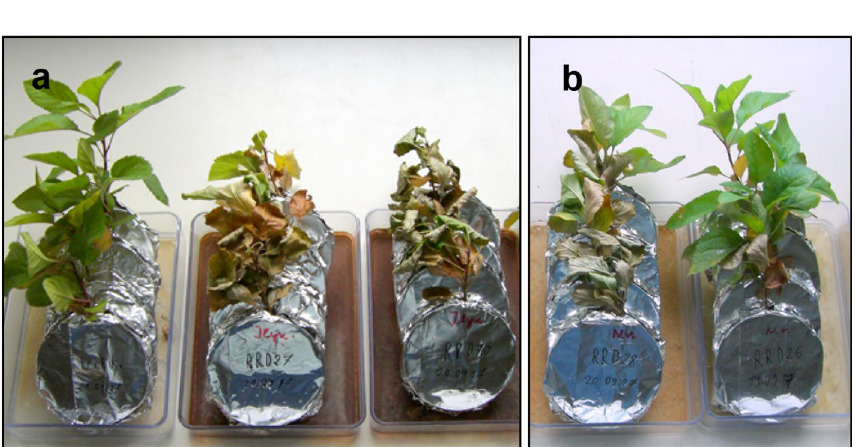
Figure 10. Perlite assay with M26 test plants grown in pure Perlite plus malt extract, plant reactions after 14 days. Non-inoculated control, left, and plants inoculated with isolates RRD 27 and RRD 70, both Ilyonectria robusta obtained from R. corymbifera in RRD soil from the site Heidgraben ( a ). Plants inoculated with isolates RRD 28 and RRD 26 from the site Heidgraben, both identified as Rugonectria rugulosa by HIS sequencing ( b